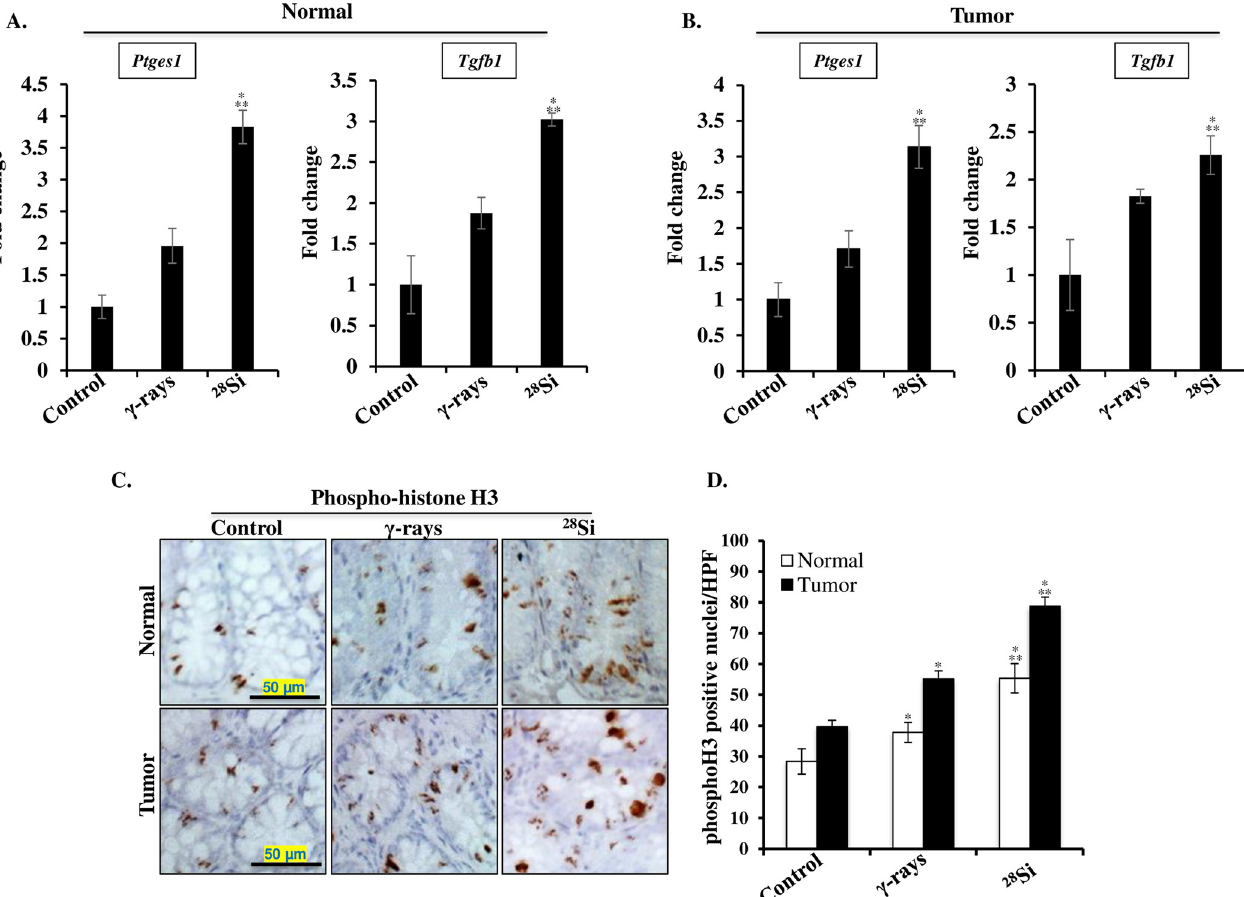
Fig 3. Greater increase in pro-inflammatory gene expression and mitotic cell population in the colonic tissues of the heavy-ion exposed mice. A) Fold change in expression of inflammation-associated genes ( Ptges1 and Tgf β 1 ) in normal colon. B) Fold change in expression of Ptges1 and Tgf β 1 in colon tumor. C) Representative images (200X magnification) of phospho-H3 (mitotic cells) stained tumor-free (normal) and tumor region from control, γ -rays, and 28 Si irradiated mice. D) Quantification of pH3 positive nuclei per high-powered microscopic field (HPF) in colonic normal and cancer tissues. All bars show mean ± SEM and � indicates a p-value < 0.05 compared to control and �� indicates p < 0.05 compared to the γ exposed group.